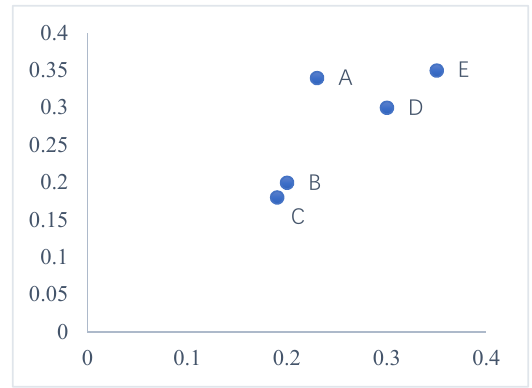
Figure 4. Clustering result of 2D space based on the sentences in Table 2.